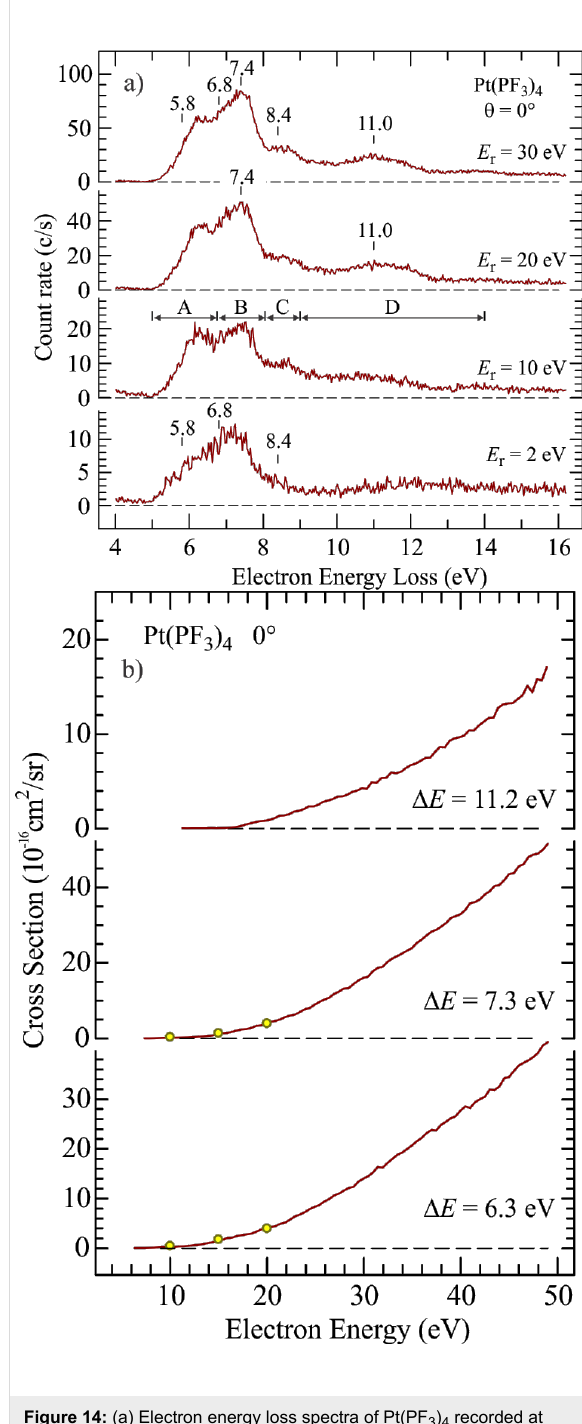
Figure 14: (a) Electron energy loss spectra of Pt(PF 3 ) 4 recorded at 0° angle with varying residual energies. The sections marked A–D in the third panel represent the energy ranges in which integration is performed to obtain absolute values. (b) Absolute electron excitation cross sections as a function of electron energy integrated over the energy loss ranges signified as A, B and D in Figure 14a. These cross sections are recorded at 0° angle and electron energy losses of 6.3 eV, 7.3 eV and 11.2 eV. Both figures (a) and (b) are reproduced with permission from [13], Copyright (2011) American Institute of